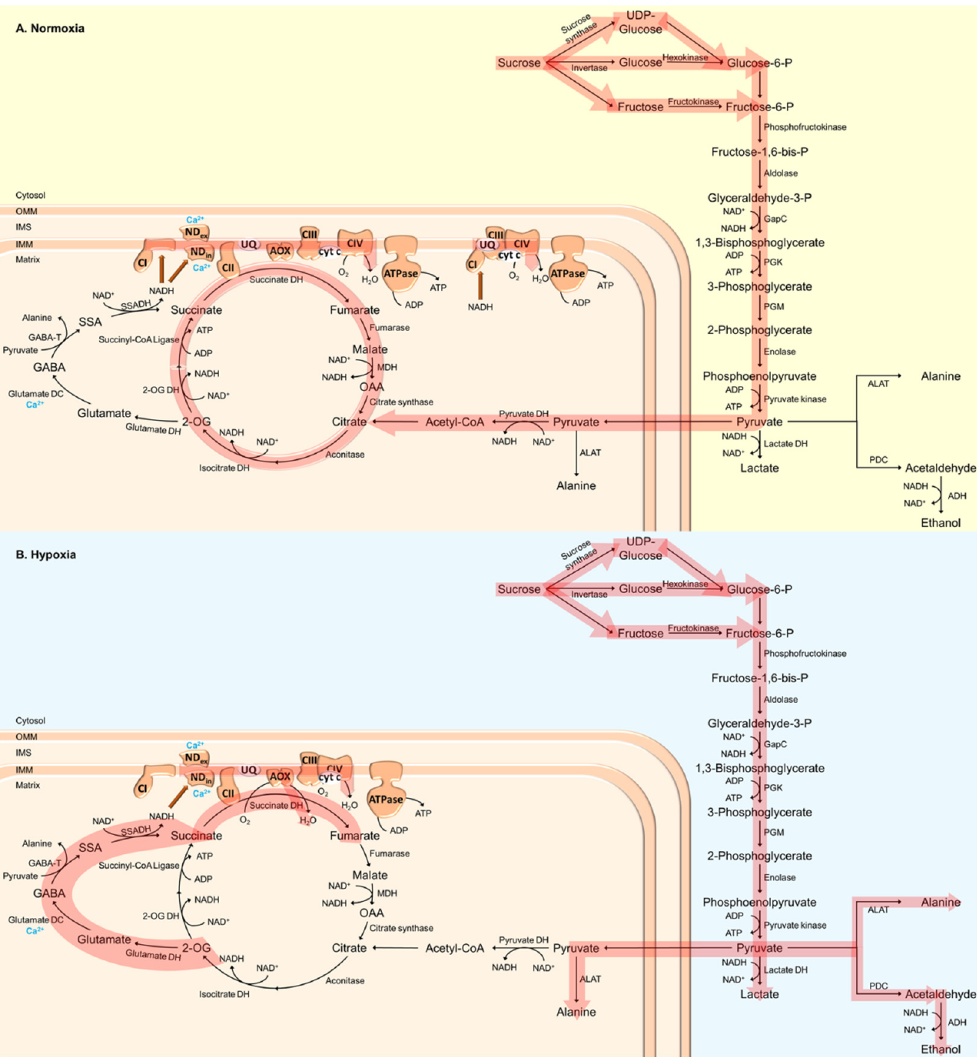
Figure 1. Schematic visualization of plant respiratory metabolism under ( A ) normoxic and ( B ) hy- poxic conditions. Under low O 2 conditions, ATP generation via oxidative phosphorylation